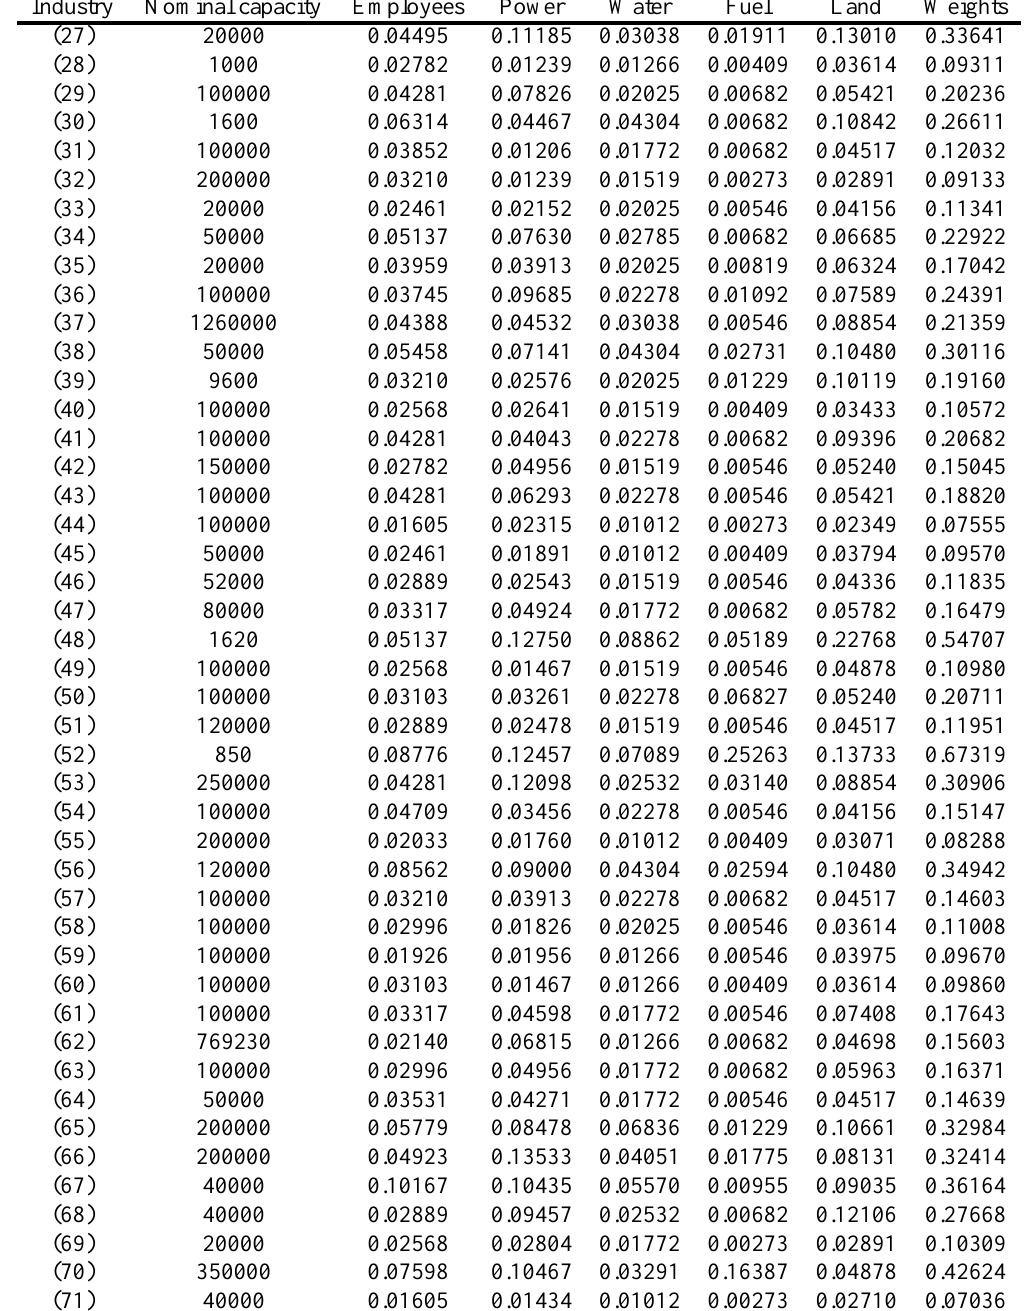
The obtained results in Table 2 led to developing a classification for IAI as